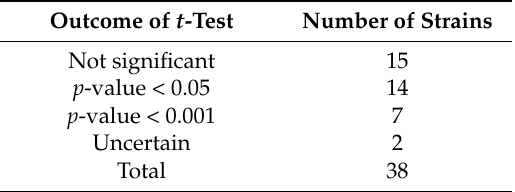
Table 3. csgD qualitative PCR significance for selected mutants.